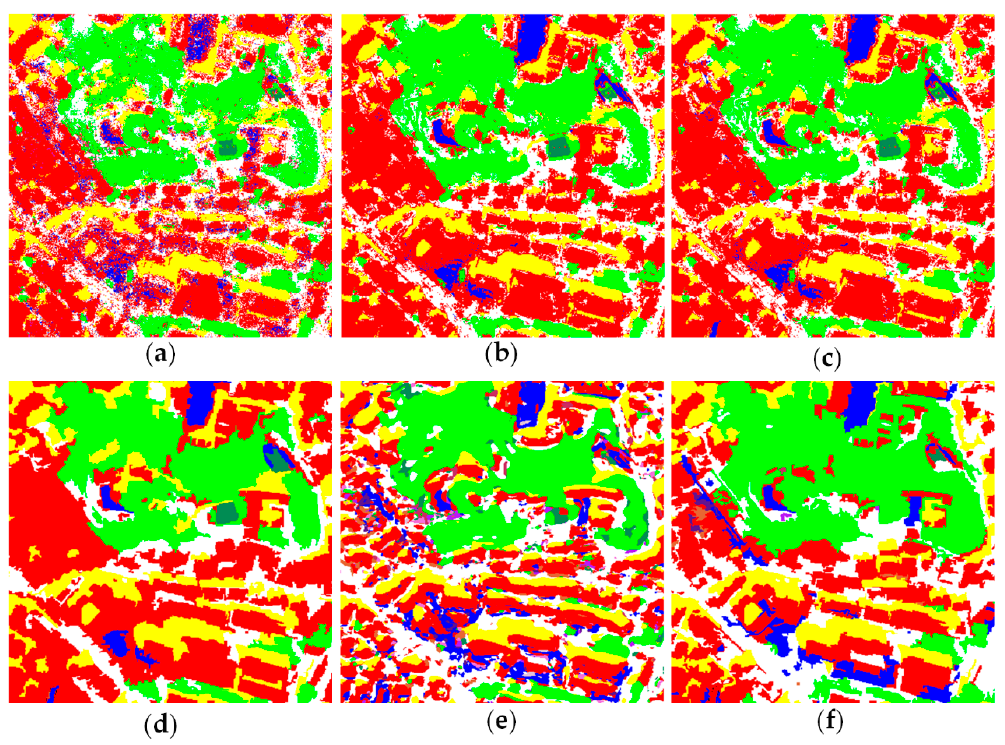
Figure 8. Local details of the classification results in hilly city area. ( a ) Raw; ( b ) SS; ( c ) OSS; ( d ) OSS-MSSC; ( e ) VGG; ( f ) VGG-MSS.